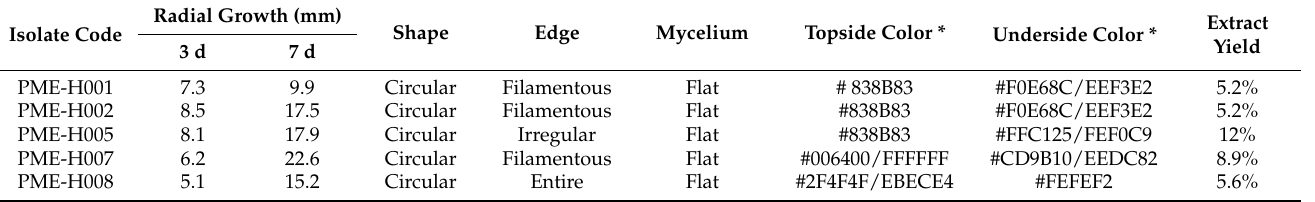
Table 1. Morphological characterization and extract yields of L. marginatus endophytic fungi with cytotoxic activity. Isolate